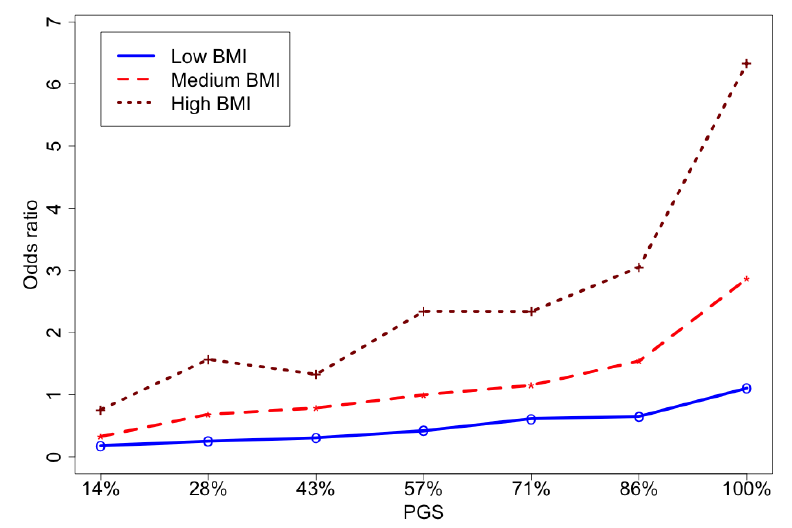
Figure 2. The odds ratios of the groups defined based on BMI and PGS levels. The group of participants with medium-level PGS (43–57%) and medium level BMI (25–30) are taken as a reference group (Supplementary Table